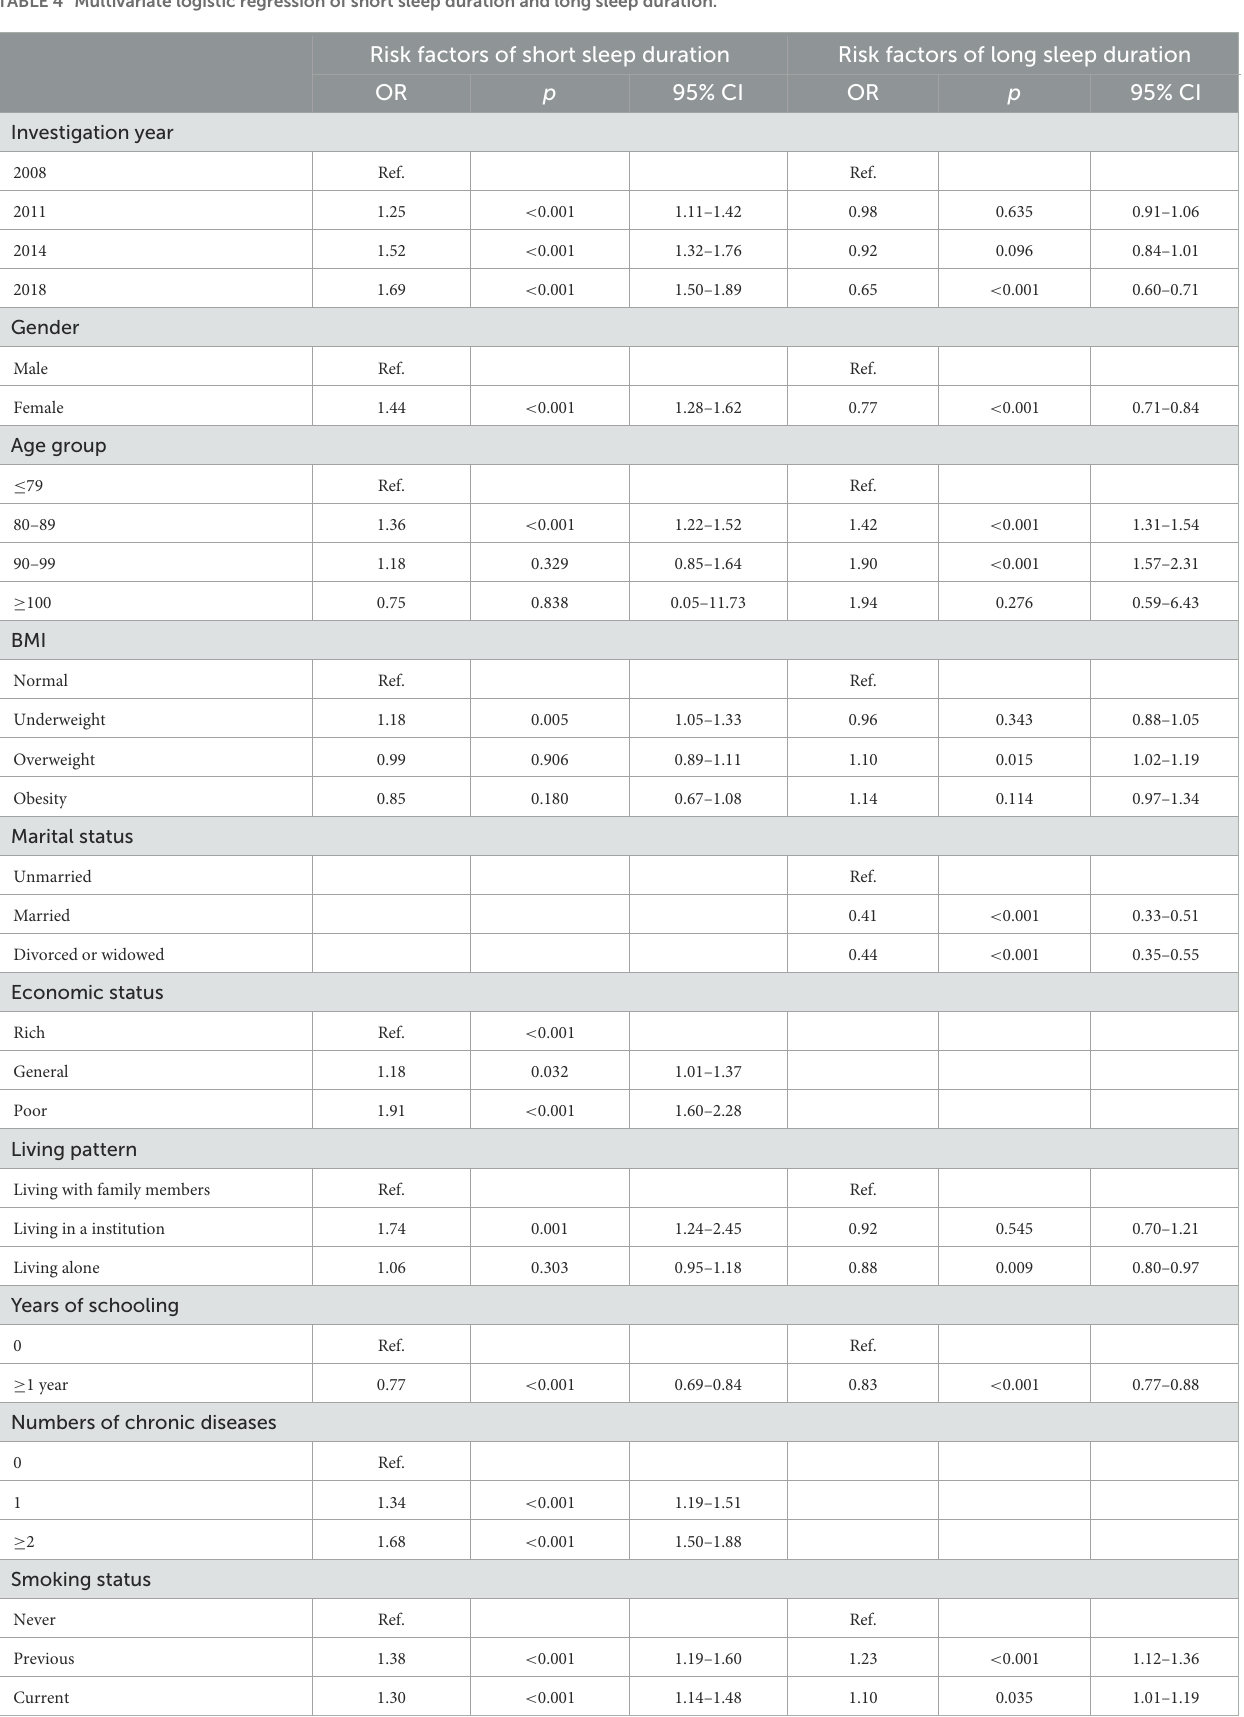
TABLE 4 Multivariate logistic regression of short sleep duration and long sleep